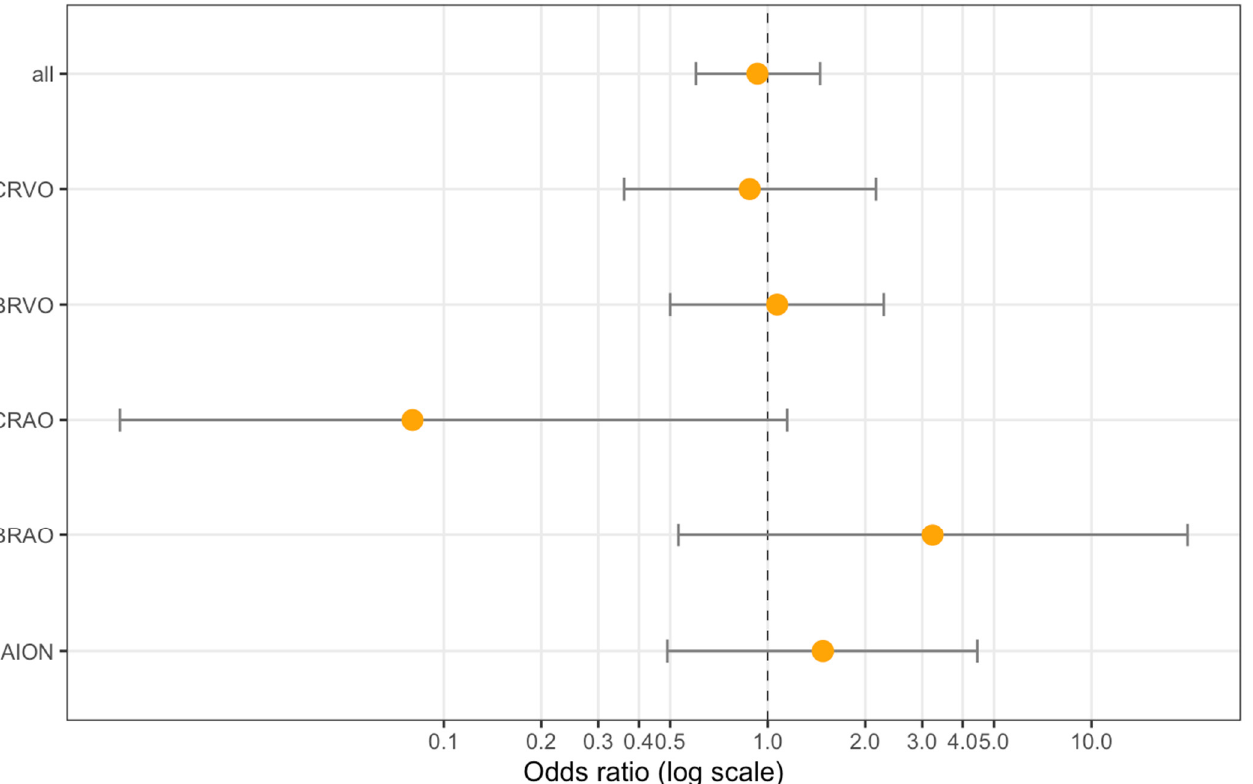
Figure 3. Forest plot of the association analysis between the SARS-CoV-2 vaccination status in subjects with RVOD (4 weeks prior to diagnosis) compared to population-based age- and sex-matched controls from the Gutenberg Health Study. A conditional logistic regression analysis with adjustment for diabetes, obesity, arterial hypertension, smoking, and the use of anticoagulation. CRVO = Central Retinal Vein Occlusion; BRVO = Branch Retinal Vein Occlusion; CRAO = Central Retinal Artery Occlusion; BRAO = Branch Retinal Artery Occlusion; AION = Anterior Ischaemic Optic